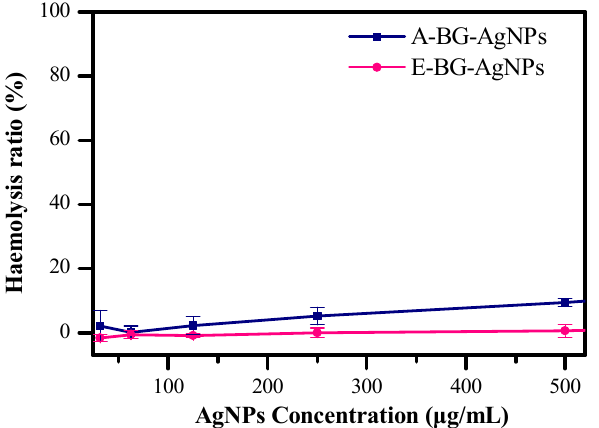
Figure 13. Hemolytic activities of BG-mediated AgNPs against human RBCs (n = 3).